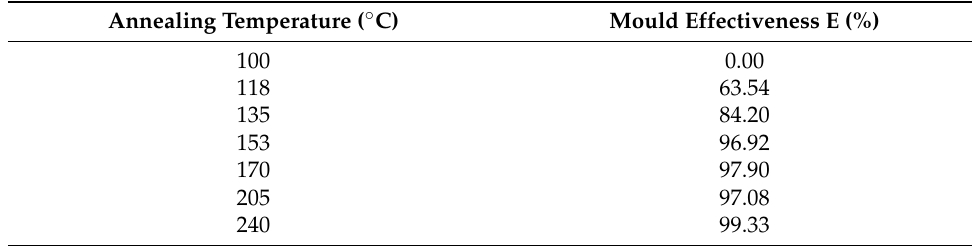
Figure 7. Height variations vs. annealing temperature: ( a ) ABS; ( b ) PLA. Table 6. ABS mould effectiveness.